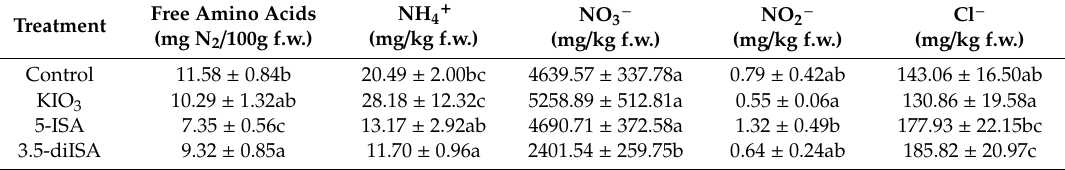
Table 5. The content of nitrogenous compounds and chlorides (means for 2018–2019).